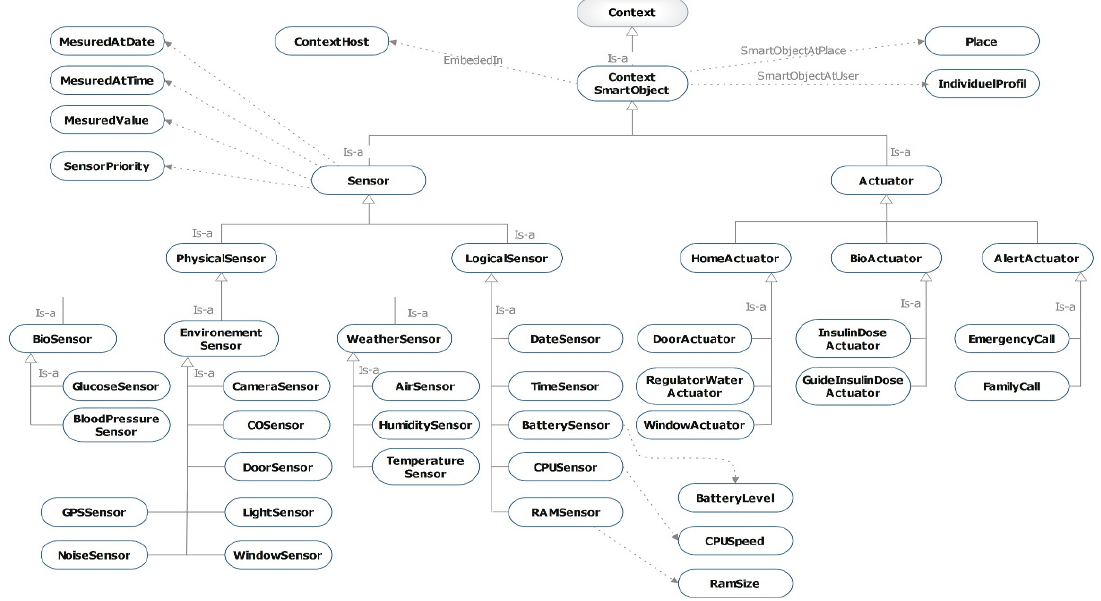
Figure 5. Smart ‐ object context sub ‐ ontology.